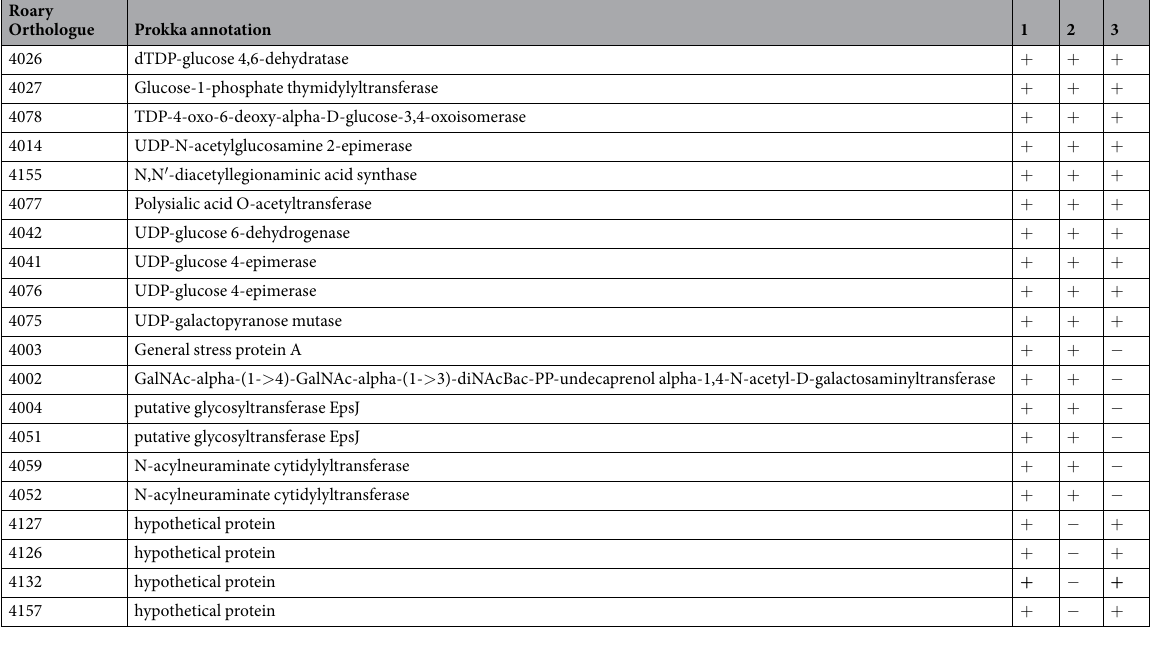
Table 3. Group of orthologues shared among C. coli